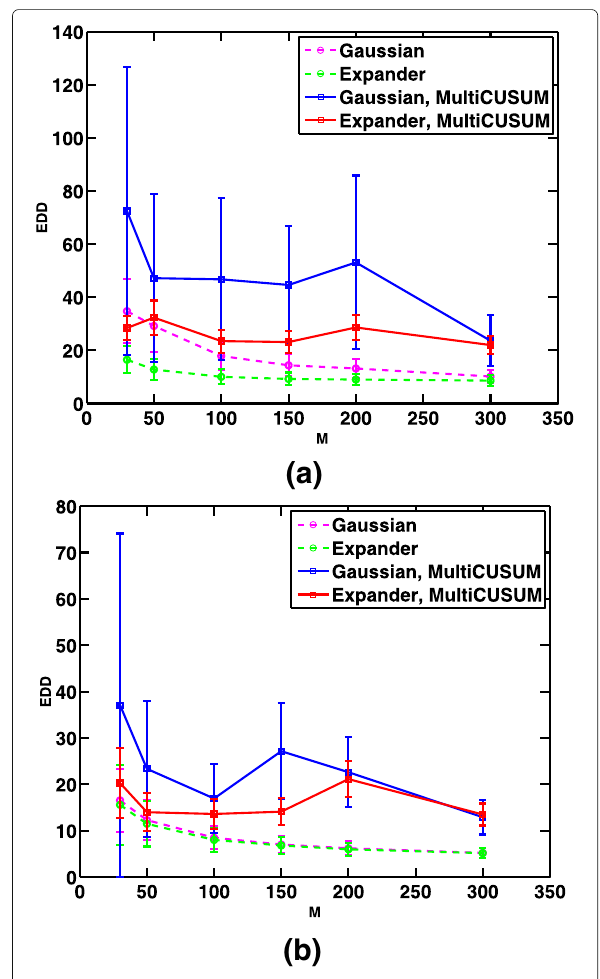
Fig. 9 Comparison of the sketching procedure with a method adapted from multivariate CUSUM. a EDDs versus various M s, when all [ μ ] i = 0.2; b EDDs versus various M s, when we randomly select 10% entries [ μ ] i to be 1 and set the other entries to be 0